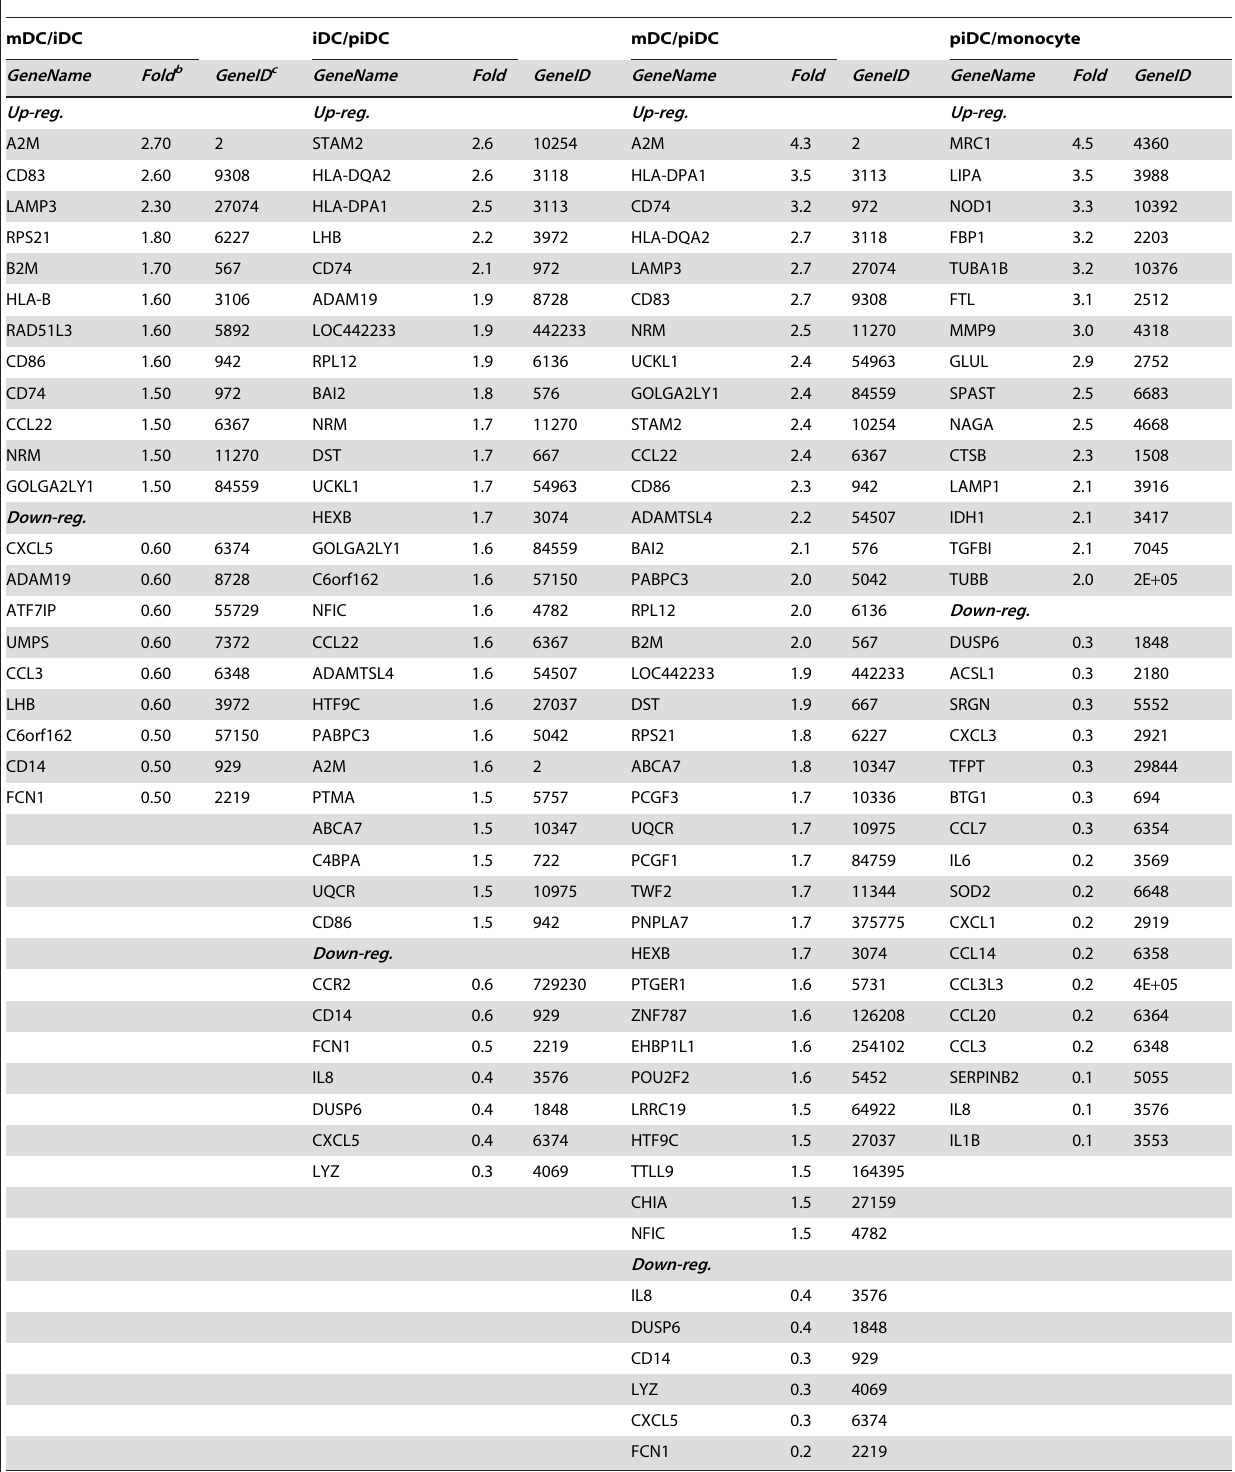
Table 2. Significant Genes during DC differentiation from piDC, iDC to mDC a .